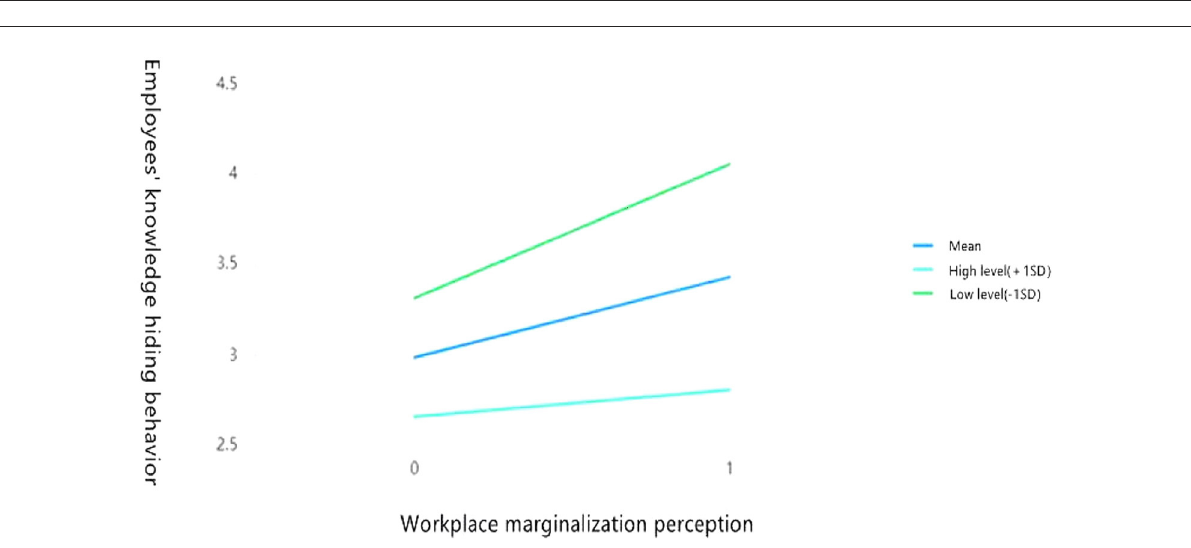
impact of workplace marginalization perception on employees’ knowledge hiding behavior is β = 0.744 ( p < 0.001), and the 95% confidence interval is (0.662, 0.826), excluding 0. This supports Hypothesis